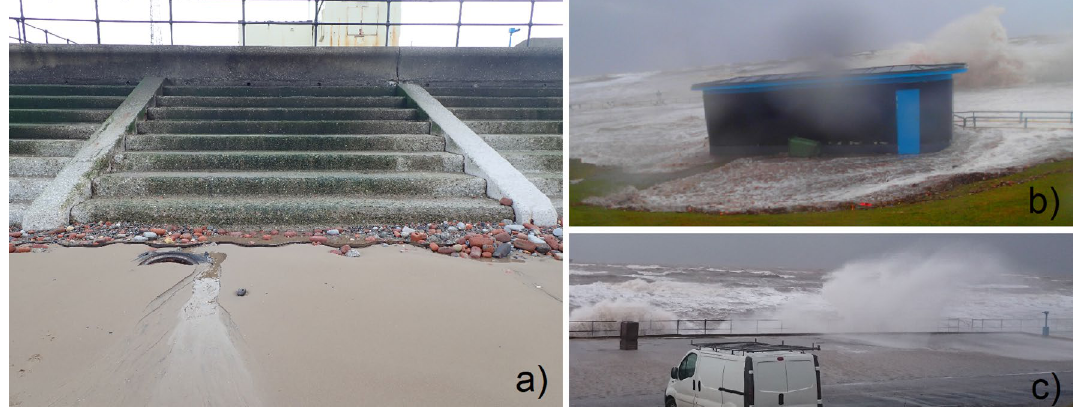
Figure 1. The case study site. ( a ) North Crosby beach, where the ageing coastal defence comprises a stepped revetment fronting a recurved sea wall. The promenade with a splash wall fronting a public car park is sometimes flooded, e.g. on ( b ) 5th December 2013, or partially flooded with the overtopping waves posing a hazard to people on the promenade and the seaward parking spaces, e.g. on ( c ) 8th February